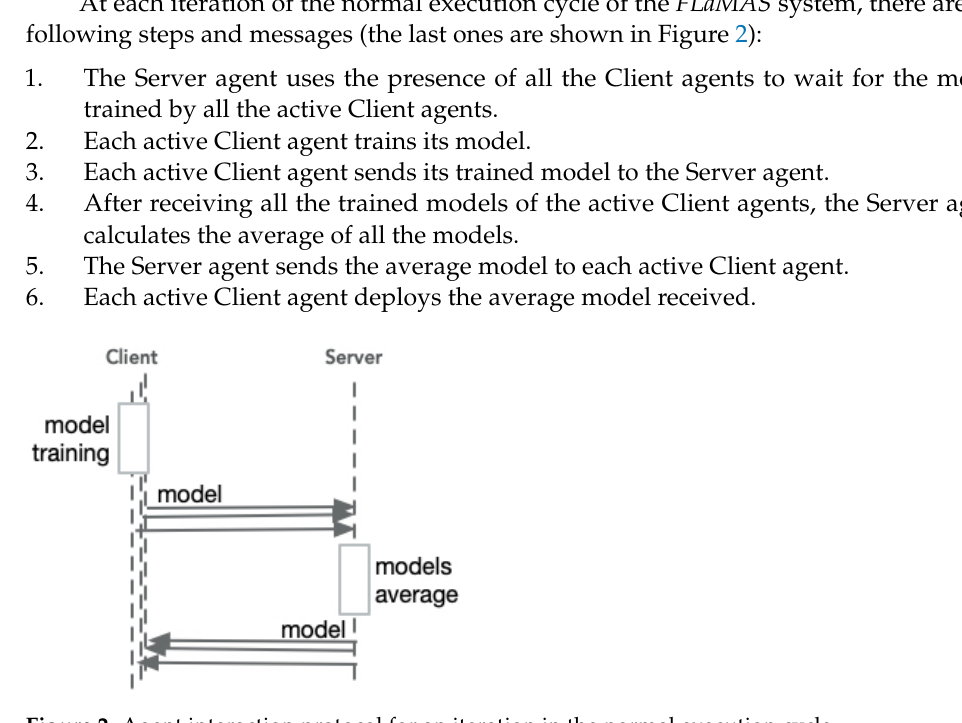
Figure 2. Agent interaction protocol for an iteration in the normal execution